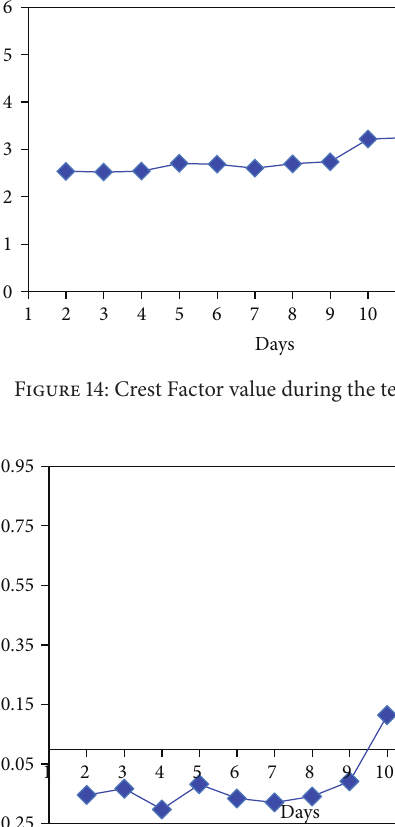
Figure 12: Peak (m/s 2 ) value during the test for all days.